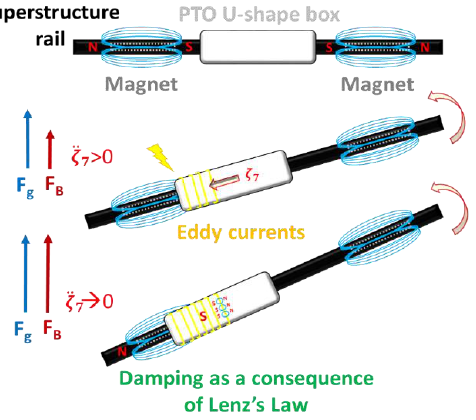
Figure 6. Schematic of the reproduced PTO’s conceptualization and operation. The unidirectional lateral TENG (Figure 7) is composed of two tribo-devices fixed at opposite ends of a polylactic acid (PLA) trough of 4.0 × 21.5 cm 2 . The tribo-devices consist of Nylon 6,6 and PTFE films with electrodes made of conductive thin silver films, which were fabricated using screen printing. Each generator has PLA supporting substrates with 2.65 × 3.75 cm 2 , onto which PTFE/silver and Nylon 6,6/silver films were attached with the same dimensions. To promote the contact separation of the two triboelectric materials of each tribo-device, two stainless steel spheres with a diameter of 12 mm and a weight of 7.2 g were used.